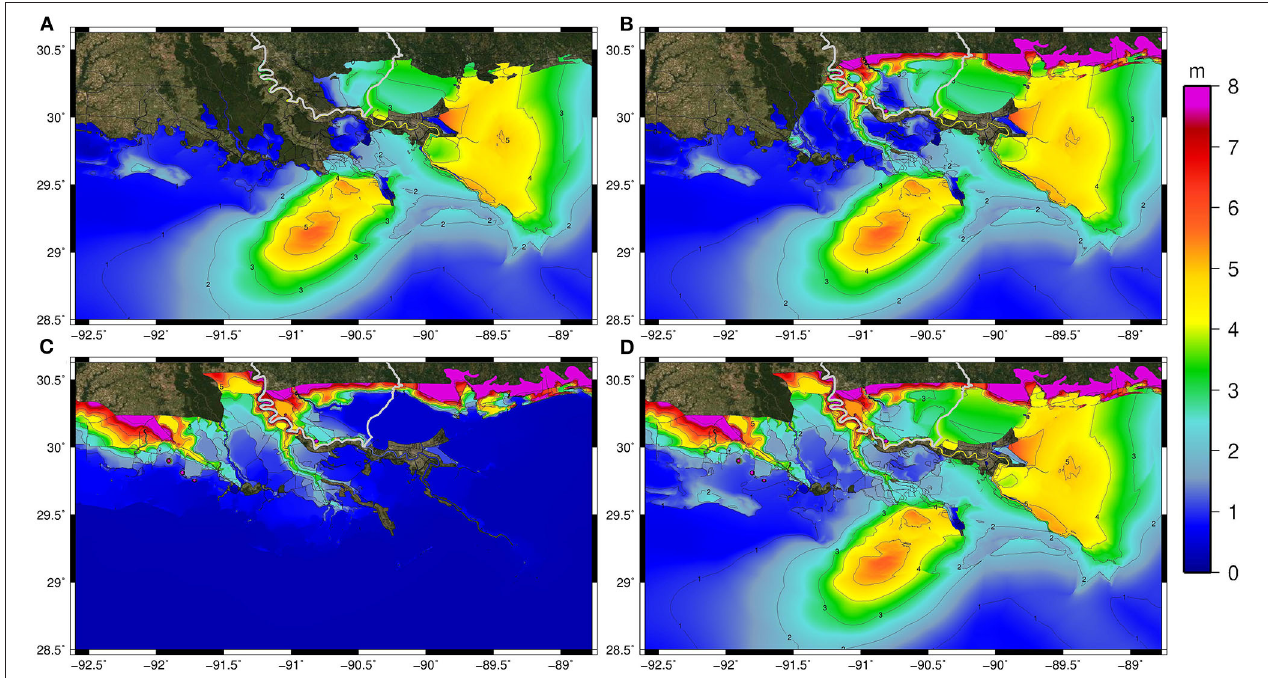
FIGURE 10 | Maximum of maximums (MOM) simulated peak water levels (m, NAVD88) for the Lake Maurepas 50-year TC events from (A) storm surge only (no rainfall), (B) storm surge and TC-driven rain, (C) antecedent rainfall only (no storm surge), and (D) antecedent rainfall, TC-driven rainfall, and storm surge in a single simulation.